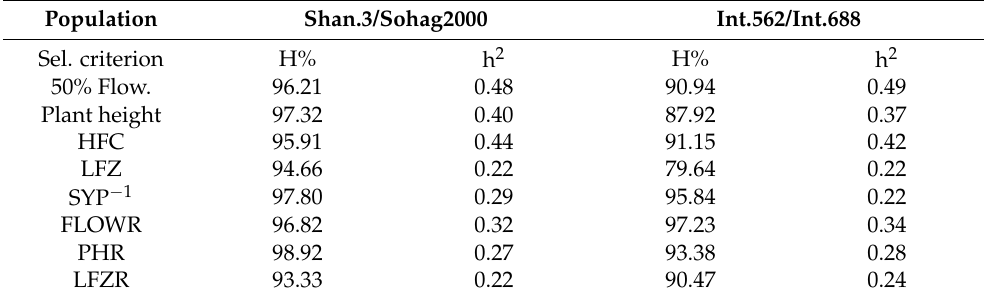
Table 5. Heritability in the broad (H%) and narrow sense (h 2 ) as estimated by parent–offspring regression (F 4 /F 3 ) for the selection criteria for both populations. Population Shan.3/Sohag2000 Int.562/Int.688 Sel. criterion H% h 2 Plant